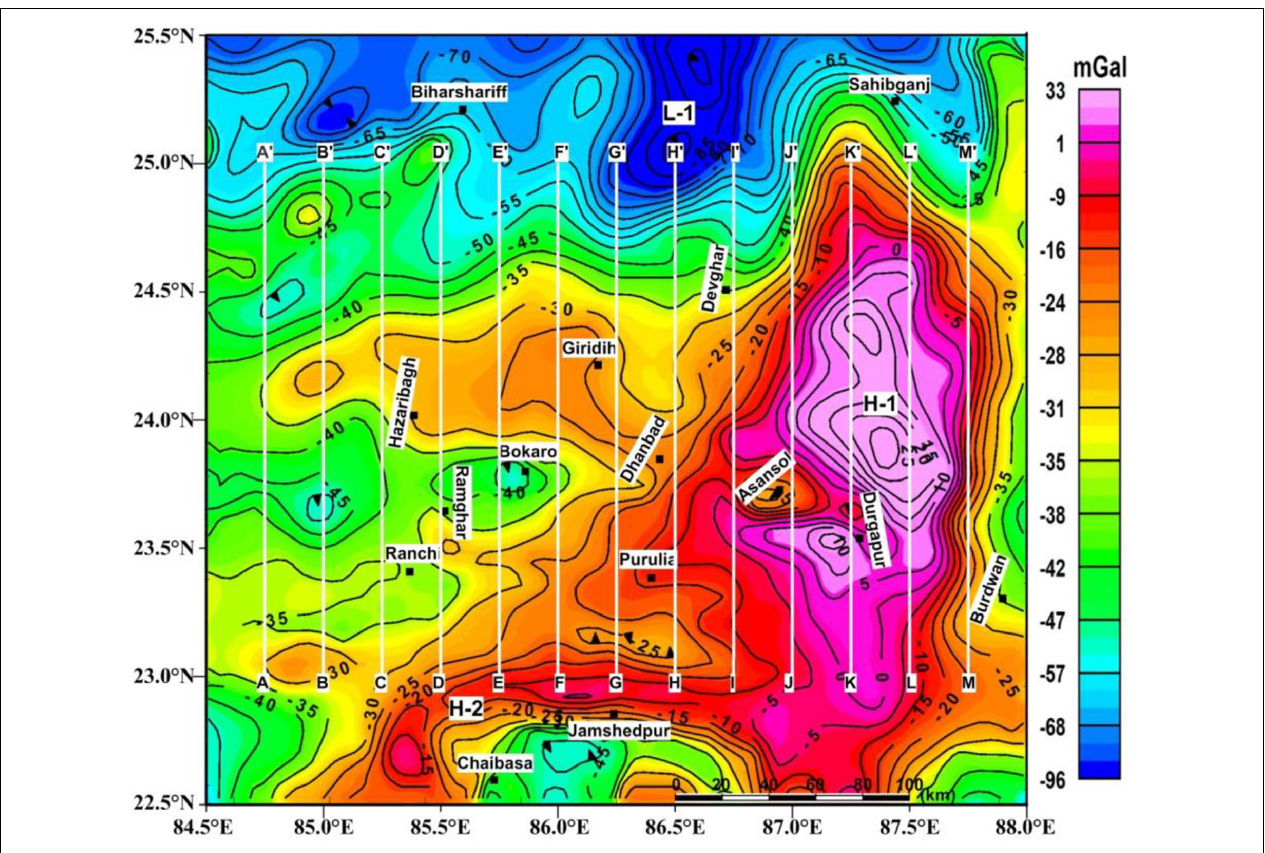
FIGURE 3 | Bouguer gravity anomaly map of the study area reconstructed from GMSI (2006). White vertical solid lines are the profiles, taken for the 2D gravity modeling. H-1 and H-2 represent the area associated with high Bouguer gravity anomalies, and L-1 represents the area with low Bouguer gravity